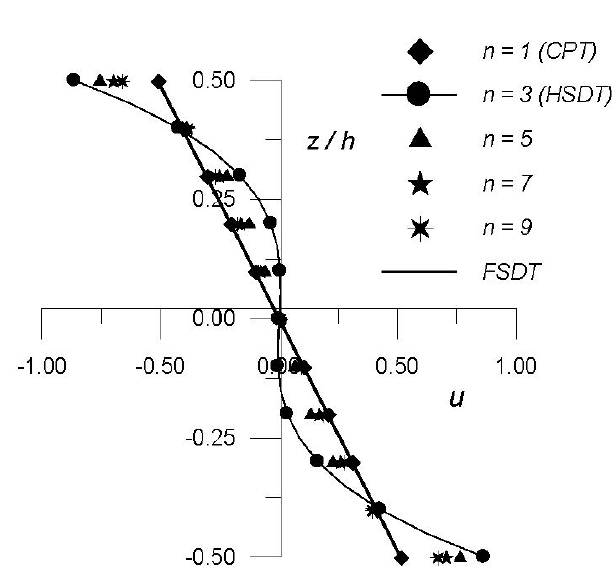
Figure 9: Through thickness distribution of in-plane